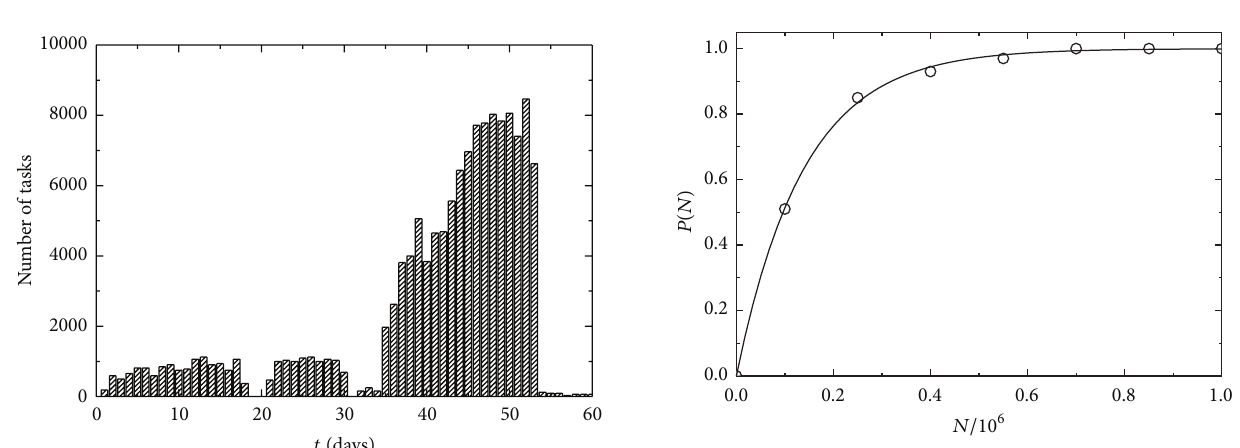
Figure 3: The number of successful tasks completed versus time (in days) for the first phase of the BOINC experiment.